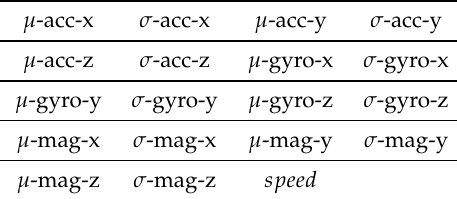
Table 3. List of extracted features from the collected